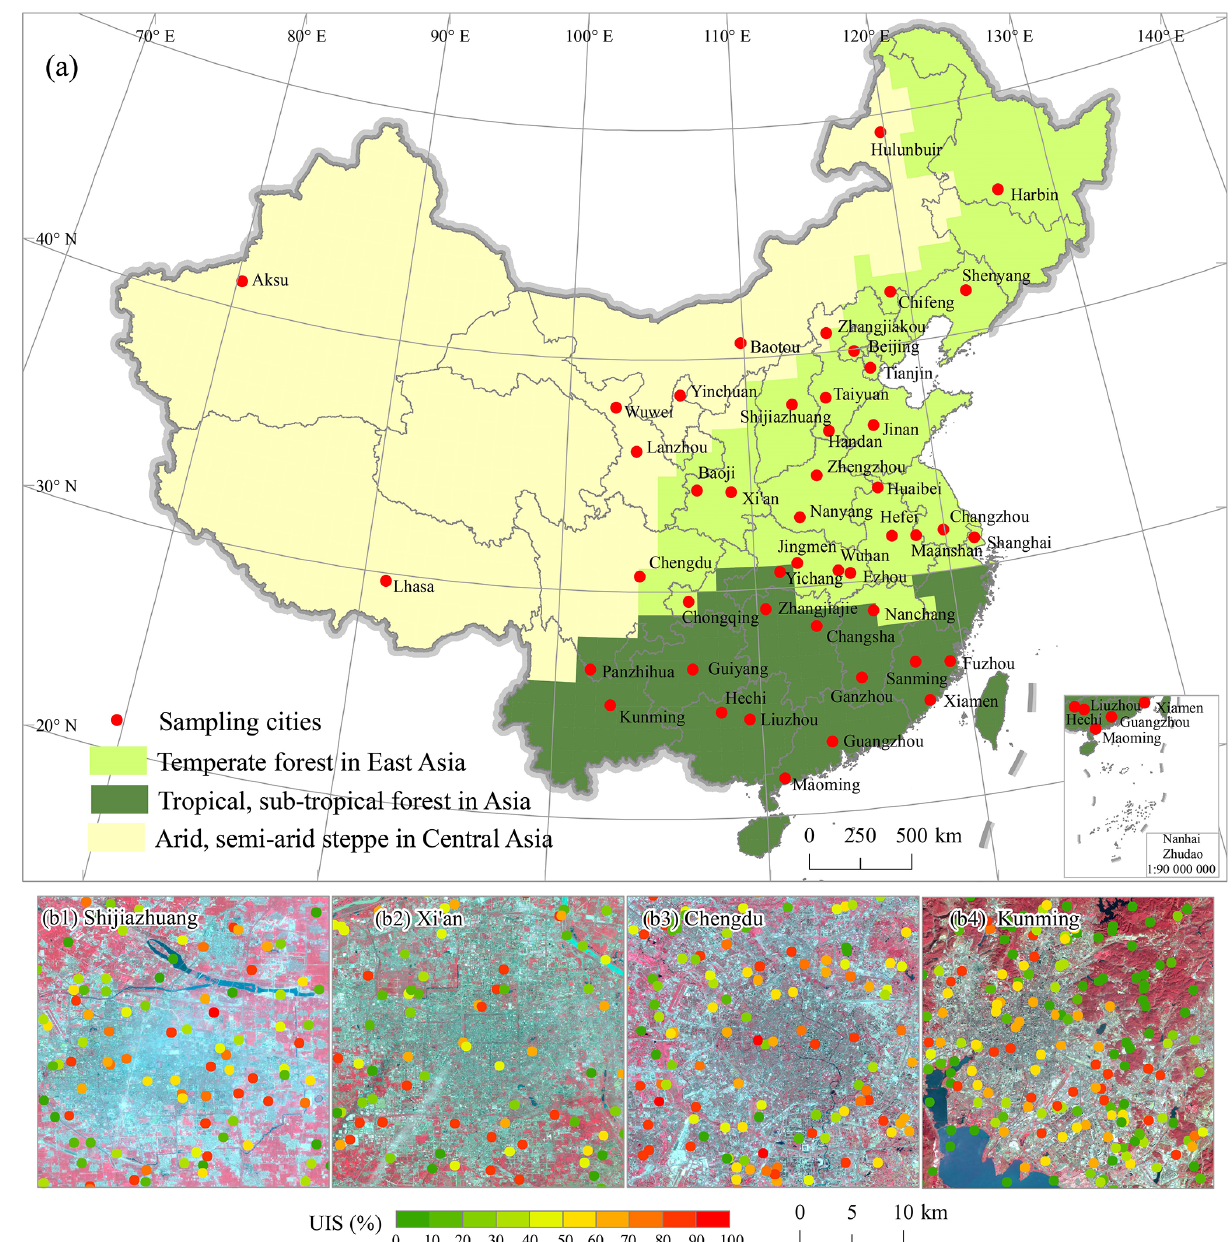
Figure 5. Distribution of sampling cities in China and training samples in selected cities. The images were provided by the Geospatial Data Cloud site, Computer Network Information Center, Chinese Academy of Sciences (http://www.gscloud.cn, last access: 13 August 2015 for Shijiazhuang, 1 July 2015 for Xi’an, 2 April 2015 for Chengdu, and 20 November 2015 for Kunming). The administrative boundaries were provided by the National Geomatics Center of China (http://www.webmap.cn, last access: 15 September